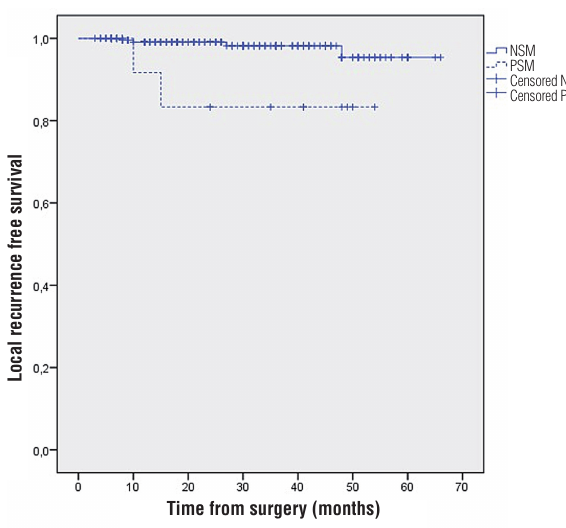
figure 1 - Local recurrence free survival by margin